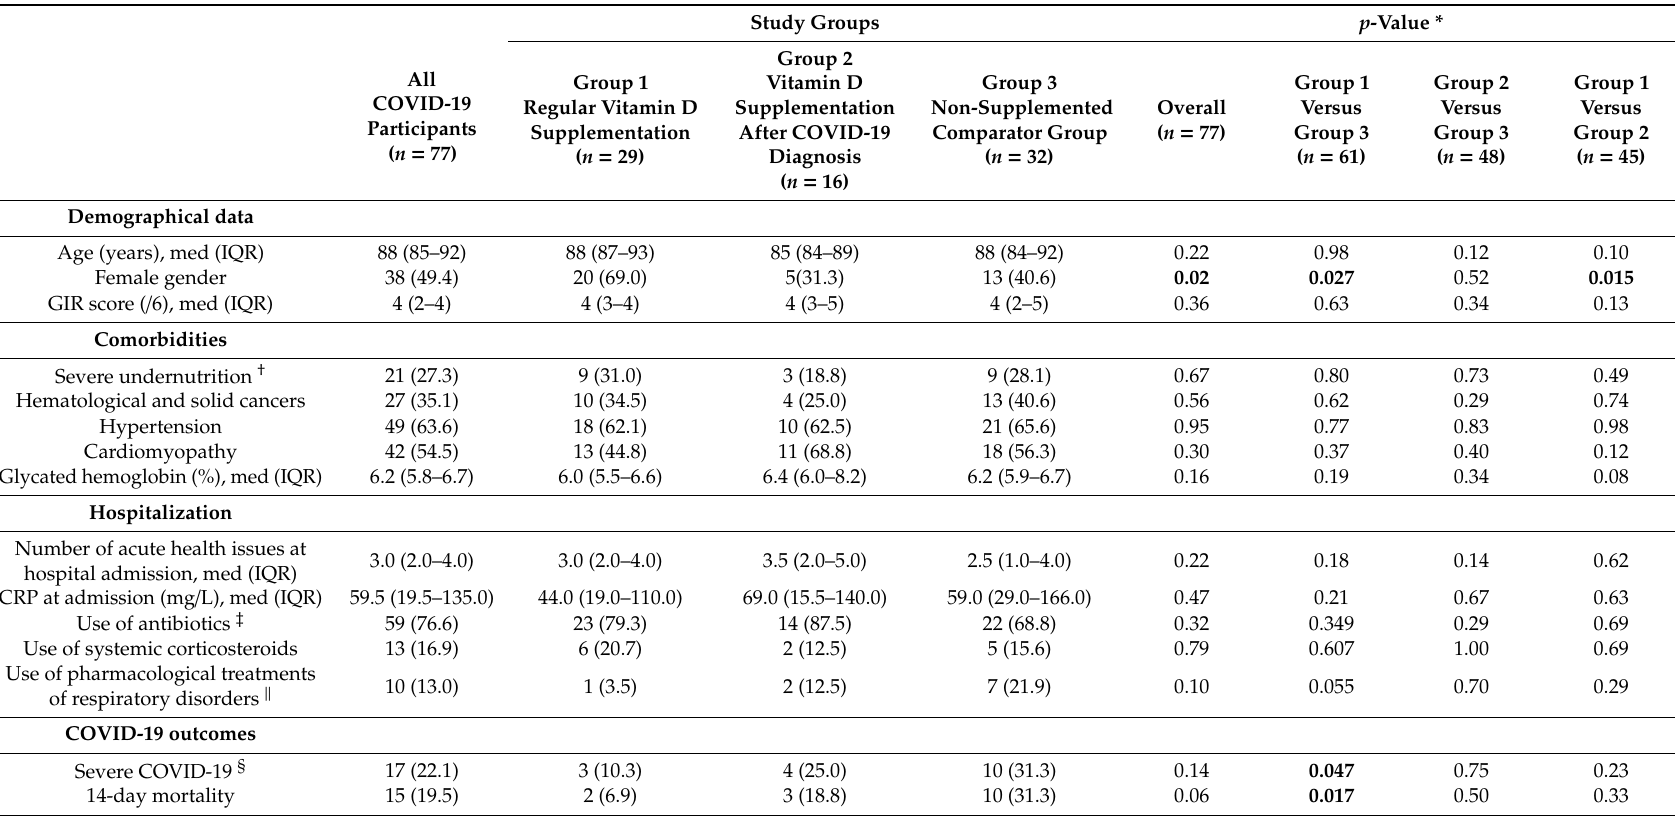
Table 1. Characteristics and comparisons of participants with COVID-19 according to the study groups ( n =